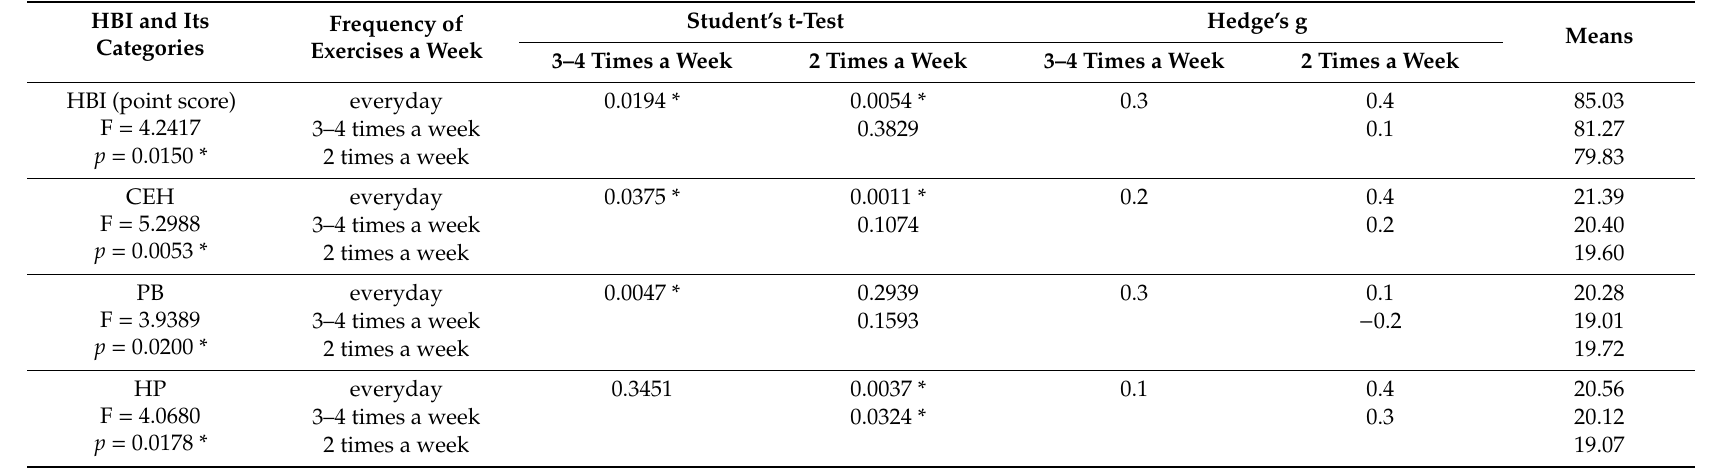
Table 4. Health behaviors of people who practice CS and MA, in relation to weekly training frequency (F-test, Student’s t-test, Hedge’s g).